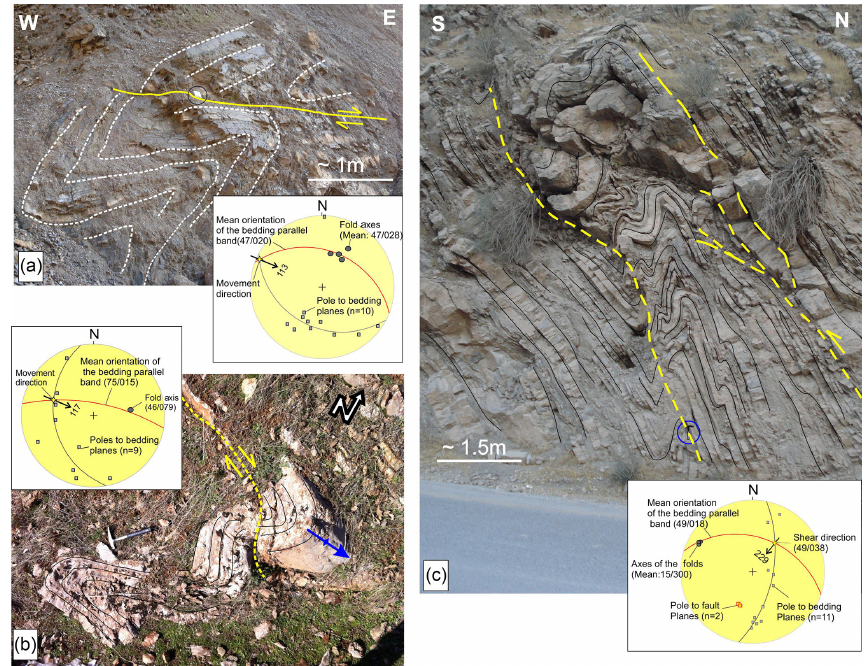
Figure 12. Bedding parallel bands in the Radiolarite zone and their kinematic interpretation using stereographic projection as (a) section view of bedding parallel bands with reclined folds, (b) plan view of bedding parallel band with plunging inclined folds and (c) bedding parallel bands with horizontal inclined folds. Equal area lower hemisphere stereographic projections show interpreted movement direction (black arrow) for the domains using asymmetric folds’ geometries. For the locations refer to Fig. 9b.